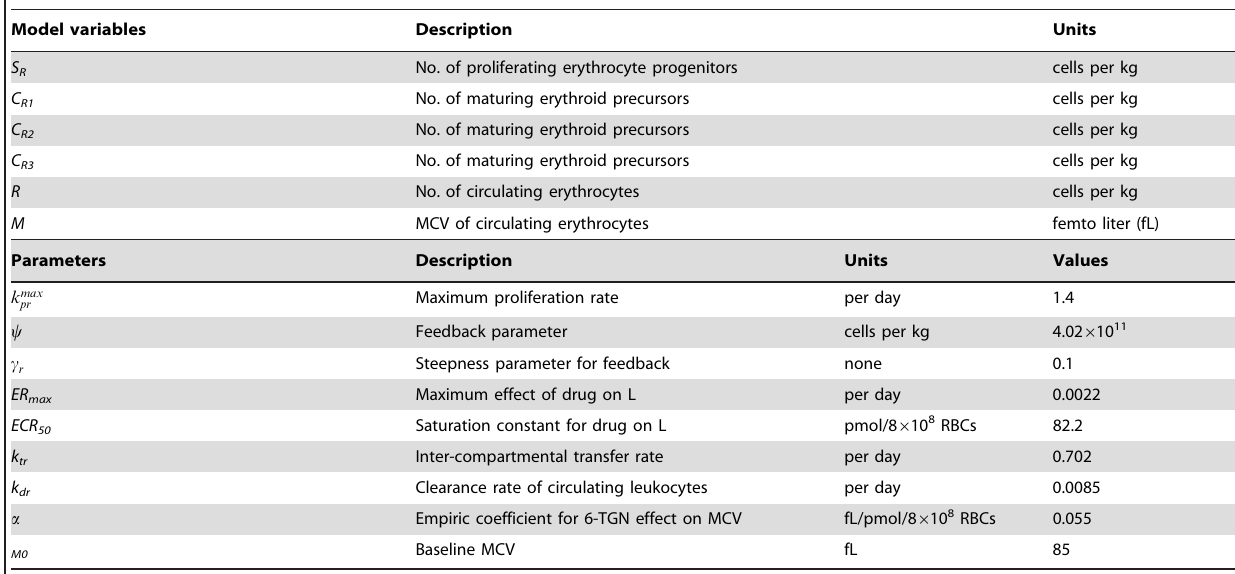
Table 3. Glossary of state variables and parameters for MCV model.